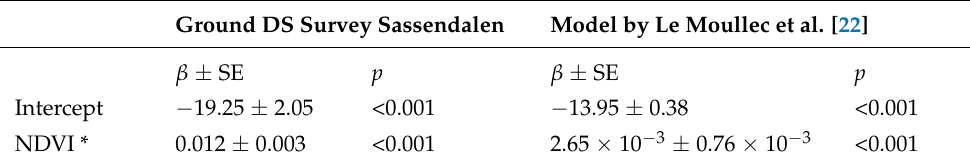
Figure A3. Density function modelling individuals per segment as a function of NDVI using a log- link quasi-Poisson model. The model was fitted using the restricted maximum likelihood (REML). Displayed above are diagnostic plots for the selected model using the function ‘gam.check’ in the package mgcv.